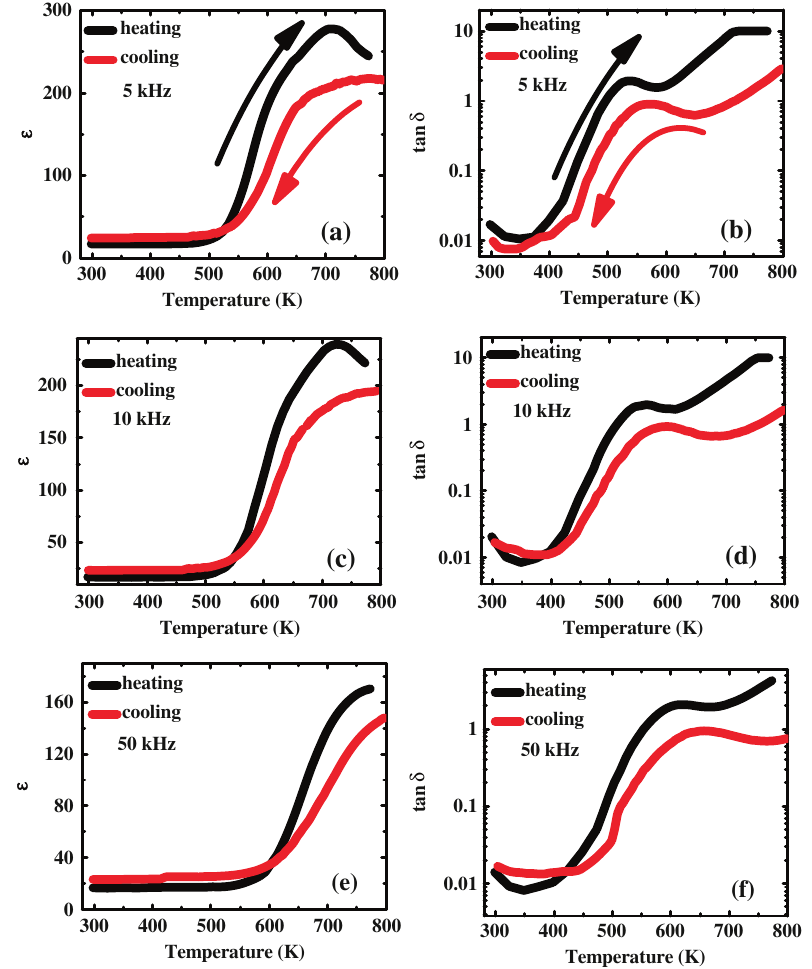
Fig. 3 a – f show temperature-dependent dielectric constant ( a , c , e ) and tangent loss ( b , d , f ) for 5, 10, and 50 kHz probe frequency, respectively. The dielectric data in cooling mode are taken on the same sample after 1 year and compared with our previous heating data. It matches well except more diffused peak in cooling mode; however, almost similar features are seen in tangent loss